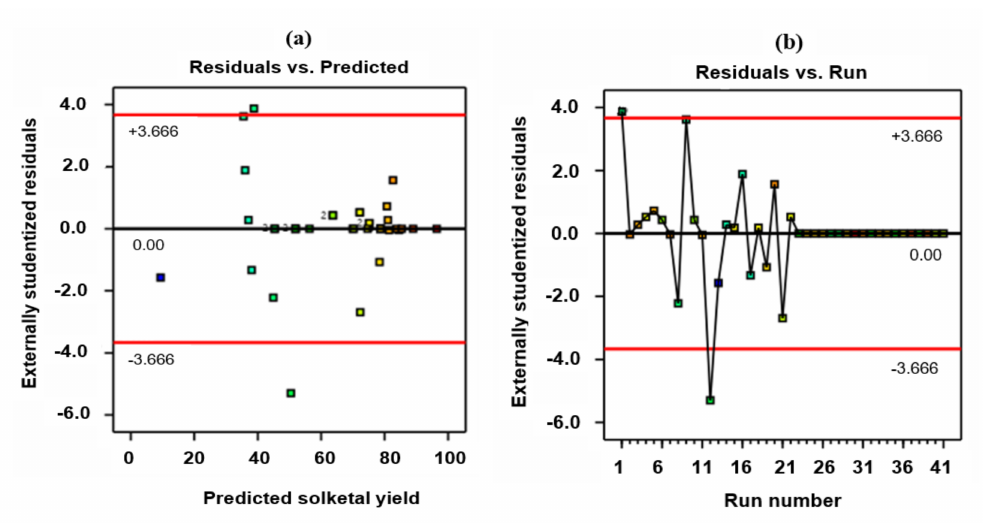
Figure 8. Predicted versus actual solketal yield.